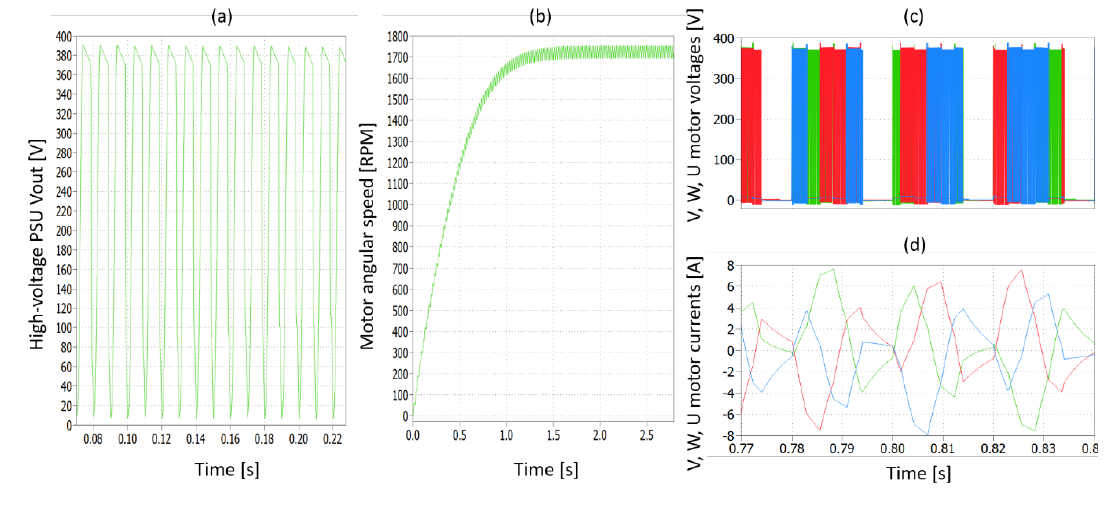
Figure 9. Fault F5_BOOST simulation results.